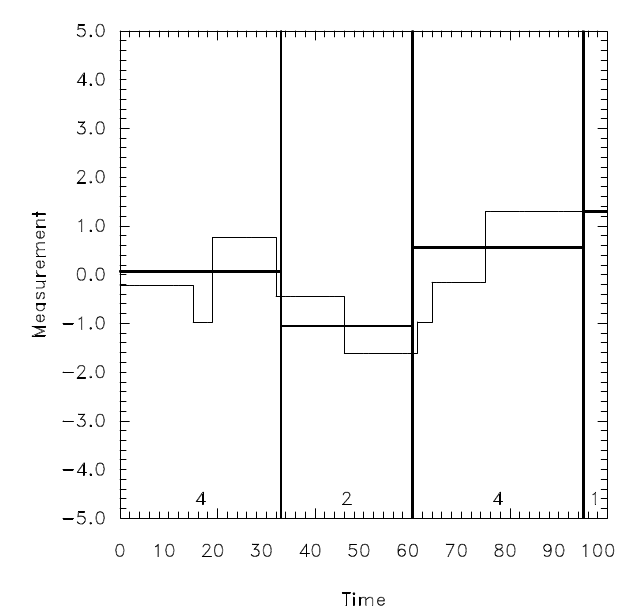
Figure 4. An example of a noise-free time series containing seven true breaks (thin step line) is tested with three random breaks de- noted by the thick vertical lines. The resulting averages for each test segment are given by thick horizontal lines. Their variation de- fines the explained variance. At the bottom of each test segment the number of independent values is given. The total number of inde- pendents is equal to 11, or, more generally, n k + 1 + k .